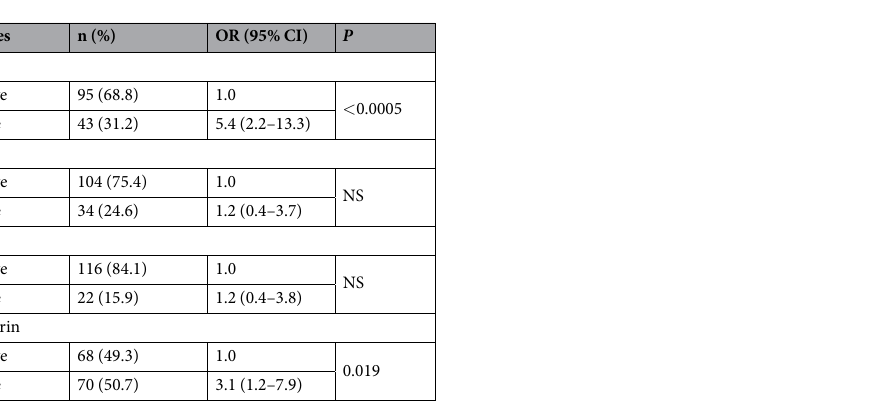
Table 2. Prediction of BRCA1 germline mutation (n = 45) by multivariate logistic regression (Series III). n: number of patients; OR: odds ratio; CI: confidence interval; P: p-values. CK: cytokeratin; EGFR: epidermal growth factor receptor. Cut-off values: CK5 positive: SI(staining index) > 0; EGFR positive: > 1%, Dako criteria; P-cadherin positive: SI > 3. BRCA2 germline mutated patients were excluded from the analysis. Missing data: EGFR: n = 1. Only cases with information on all variables were included (n = 138).